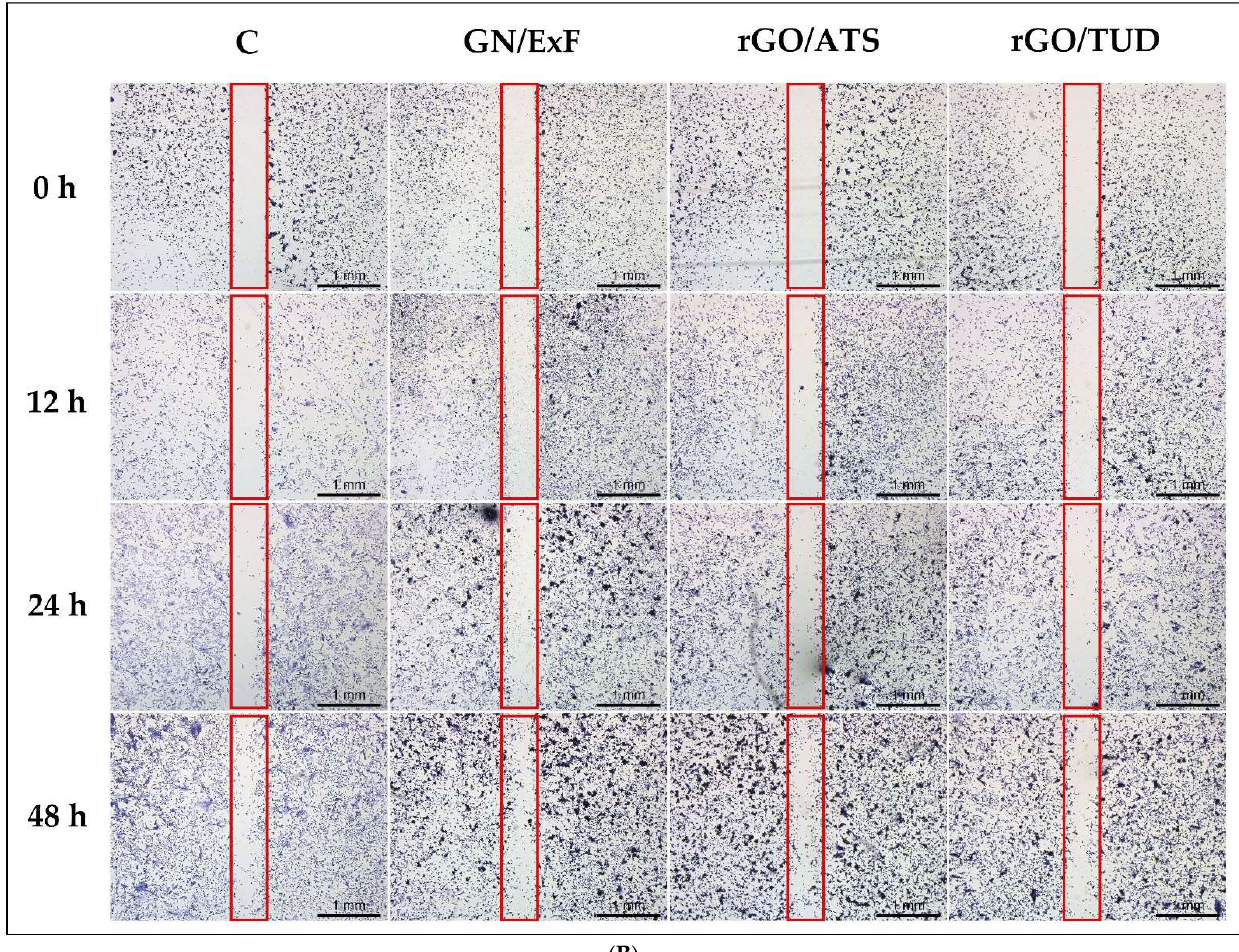
Figure 3. Analysis of U87 ( A ) and Hs5 ( B ) cell invasion and migration after 0, 12, 24 and 48 h of cultivation. U87 and Hs5 cells were exposed to GN and rGO flakes at a concentration of 25 μg/mL. Notes: For better contrast, cells were fixed and stained with the May Grünwald–Giemsa method. The scratch area is marked with a red frame. Scale bar: 1 mm. Abbreviations: rGO, reduced graphene oxide; GN, graphene; C, control group (untreated group); ExF, exfoliation; ATS, ammonium thiosulphate; TUD, thiourea dioxide.